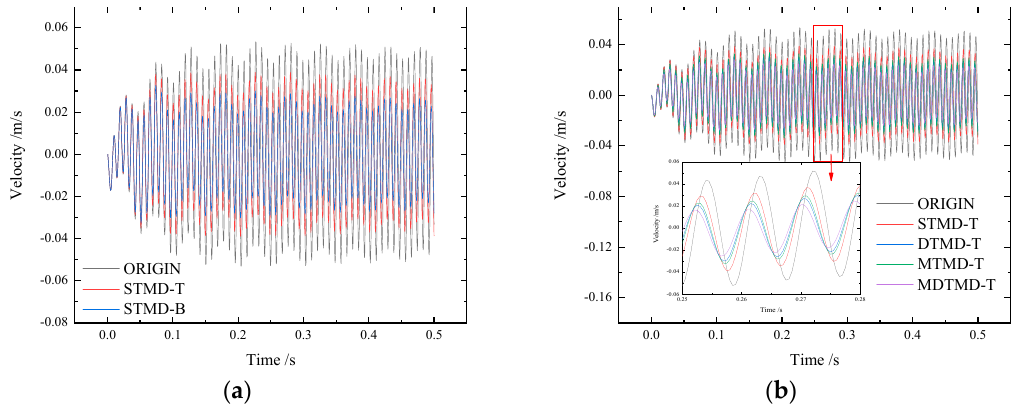
Figure 13. Comparison of structure and TMD velocity time-history curve.